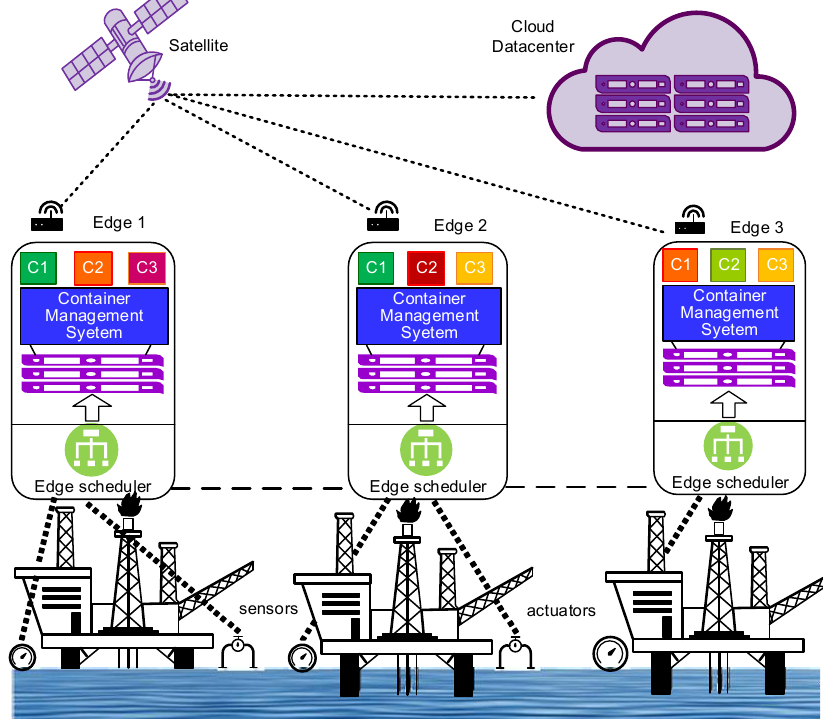
Figure 3. System architecture of collaborative edge computing for environment-friendly oil extrac- tion.